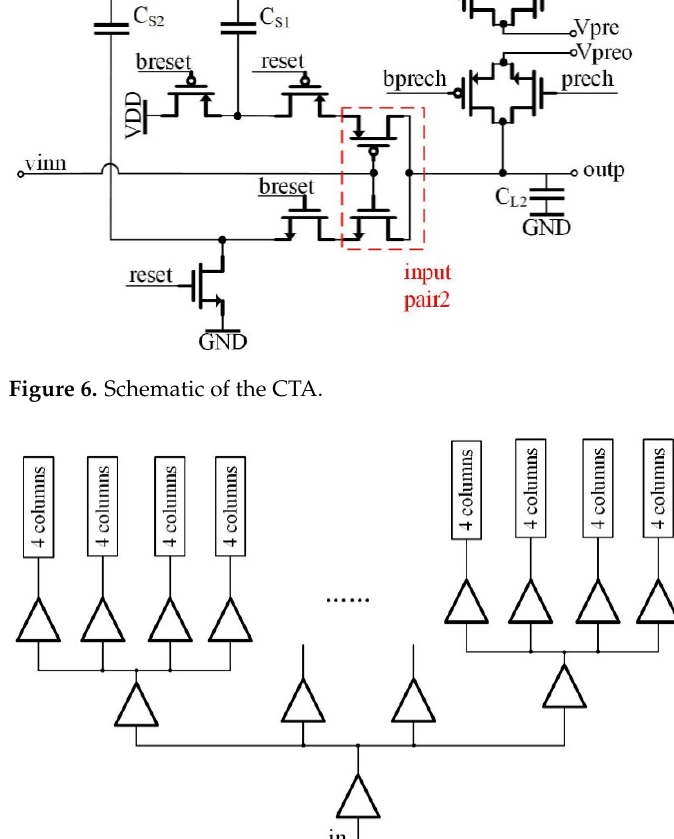
Figure 7. Distribution of the clock tree.